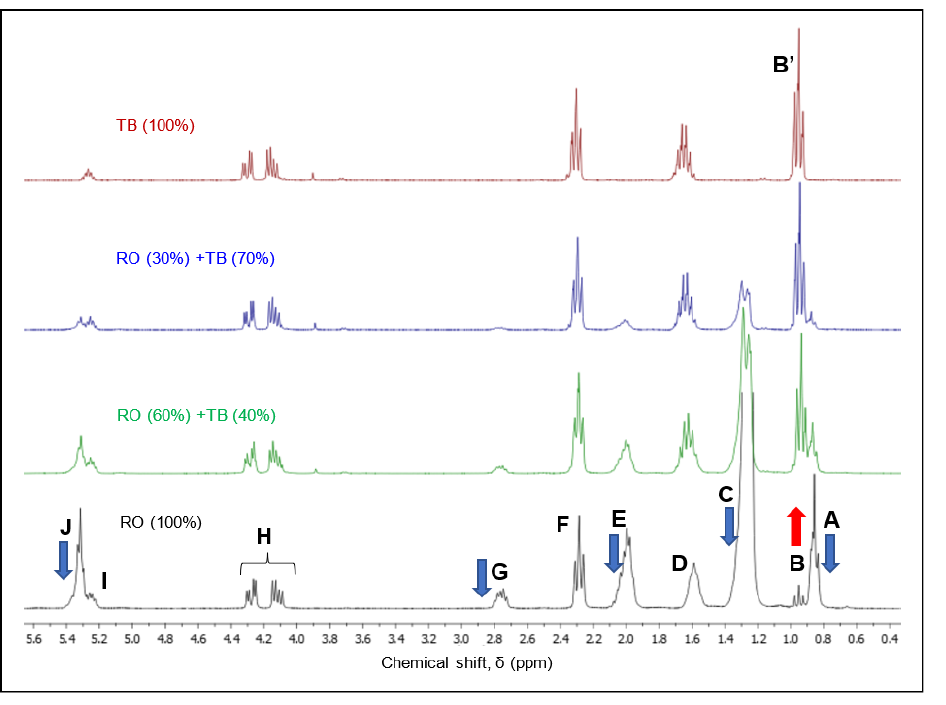
Figure 1. Comparative 1 H-NMR spectral characterization of tributyrin (TB —), rapeseed oil (RO —) and rapeseed oil–tributyrin binary mixtures: RO (30%) + TB (70%) — and RO (60%) + TB (40%) —. Letters A–J were assigned to resonances according to letters in Table 1.